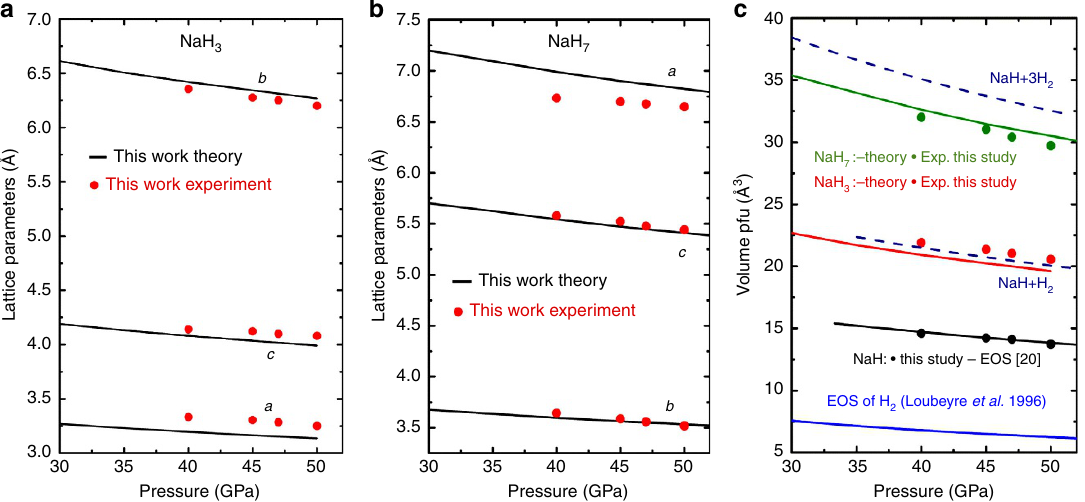
Figure 5 | Lattice parameters and equations of state of NaH 3 and NaH 7 . ( a ) Lattice parameters of NaH 3 as function of pressure. ( b ) Lattice parameters of NaH 7 as function of pressure. ( c ) Equations of state (EOS) of NaH 3 , NaH 7 in comparison with EOS of NaH and H 2 . Experimental data: green, red and black circles, theoretical predictions: green, red and black continuous lines (specified in the figure). EOS of H 2 is also shown (blue